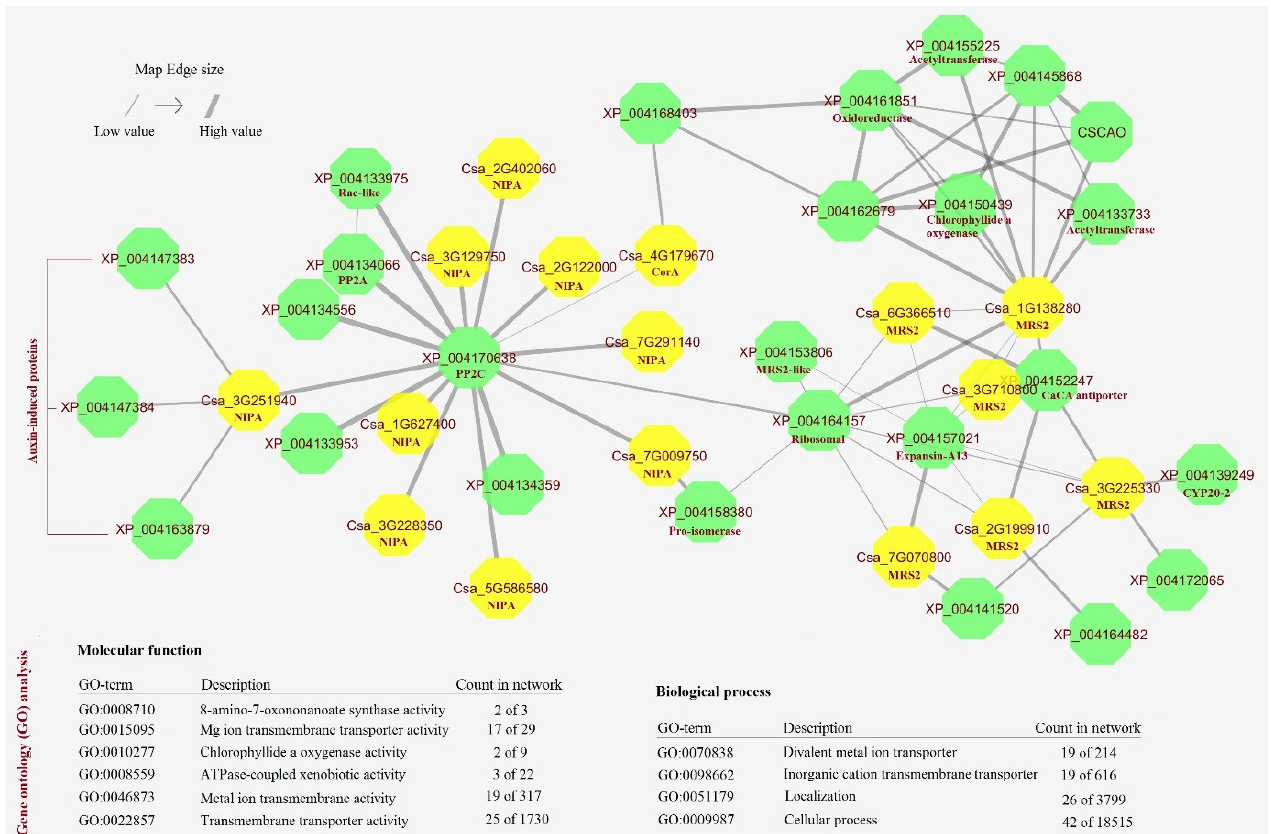
Figure 7. The interaction network of MGTs with other genes in C. sativus . The significant GO terms (FDR < 0.05) related to the network are provided based on molecular functions and biological process terms.